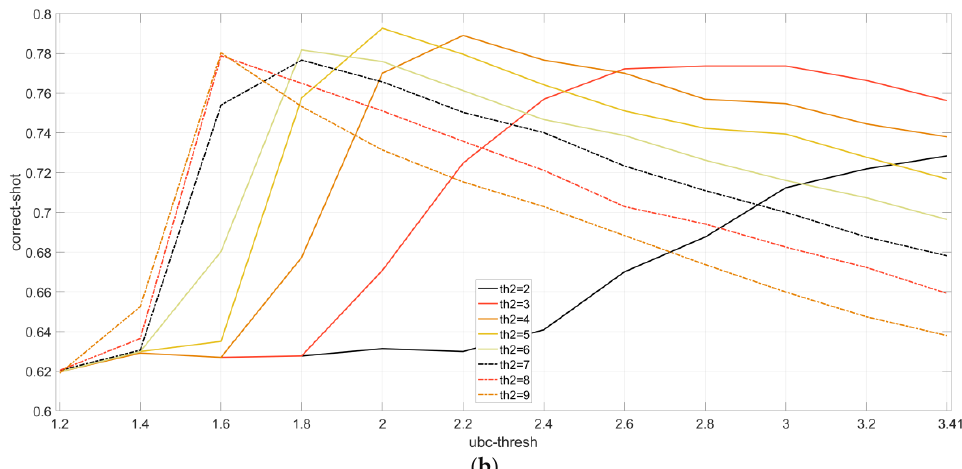
Figure 18. The experimental results using the three frames method. ( a ) Video searching; ( b ) Shot searching.